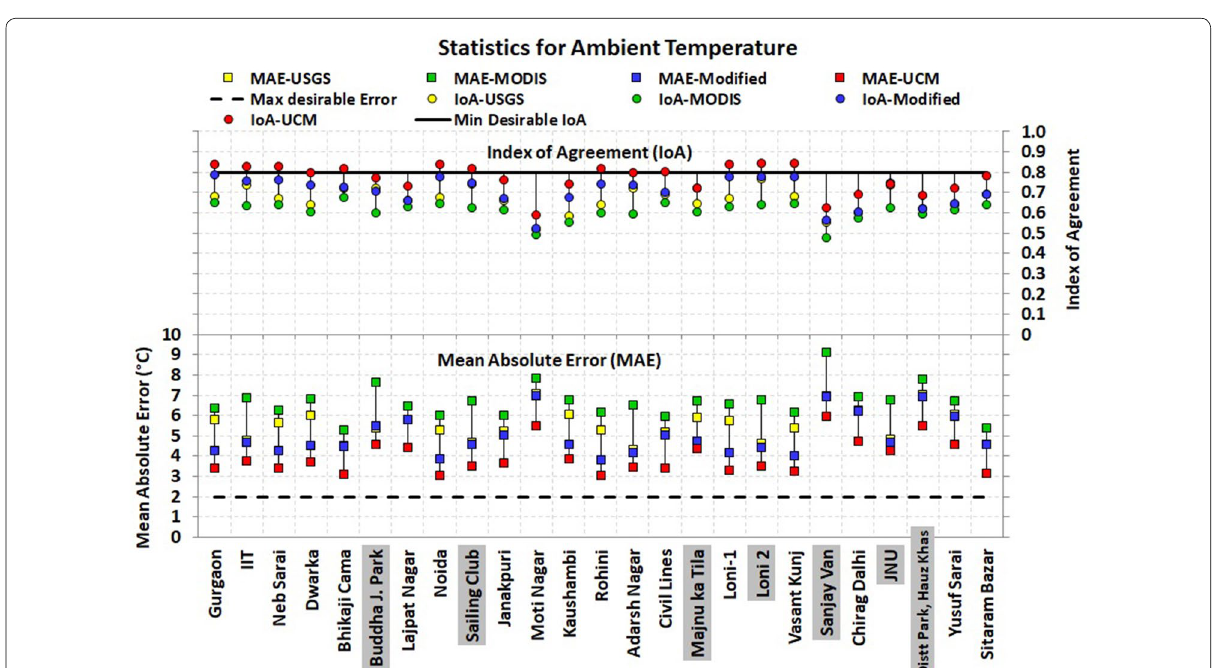
Fig. 4 Index of agreement (top) and mean absolute error (bottom) for some individual sites for near surface temperature. Shaded names indicate non-urban